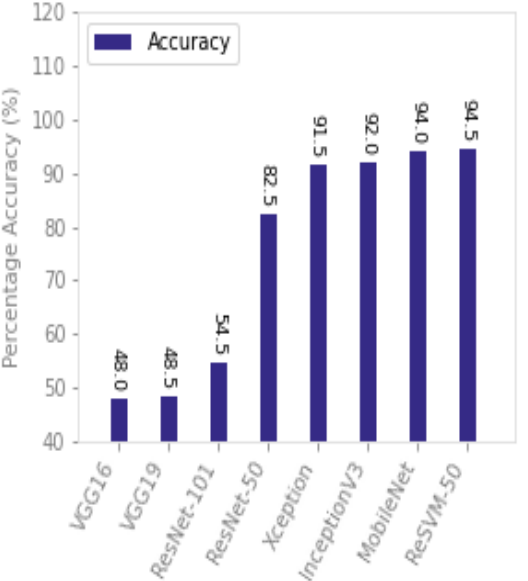
Figure 11. Comparison of ReSVM with existing state-of-the-art approaches in terms of percentage accuracy on FT-UMT dataset.